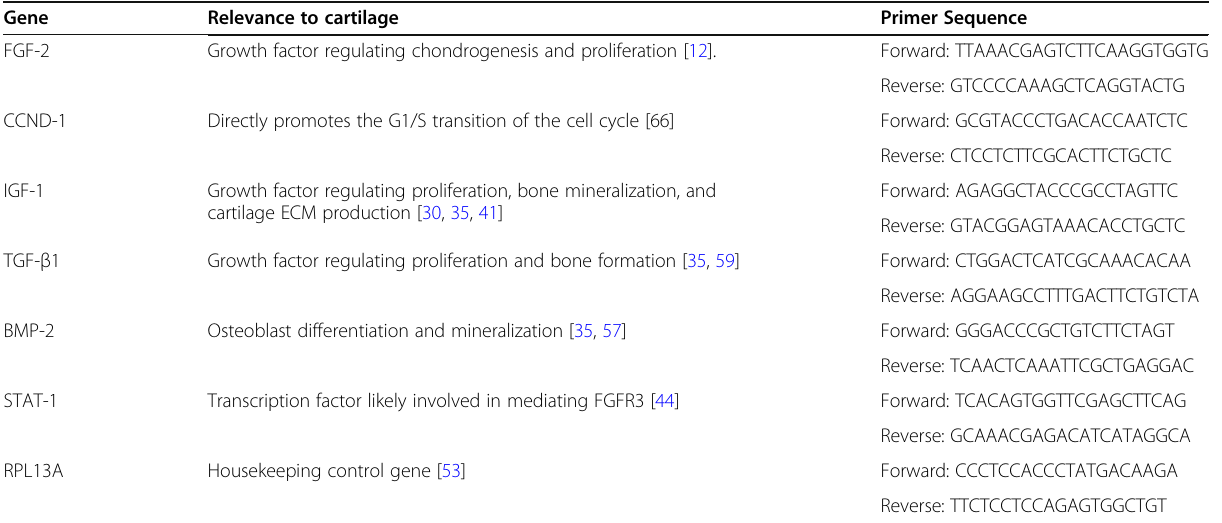
Table 1 Primers Selected for PCR Analysis (from PrimerBank)